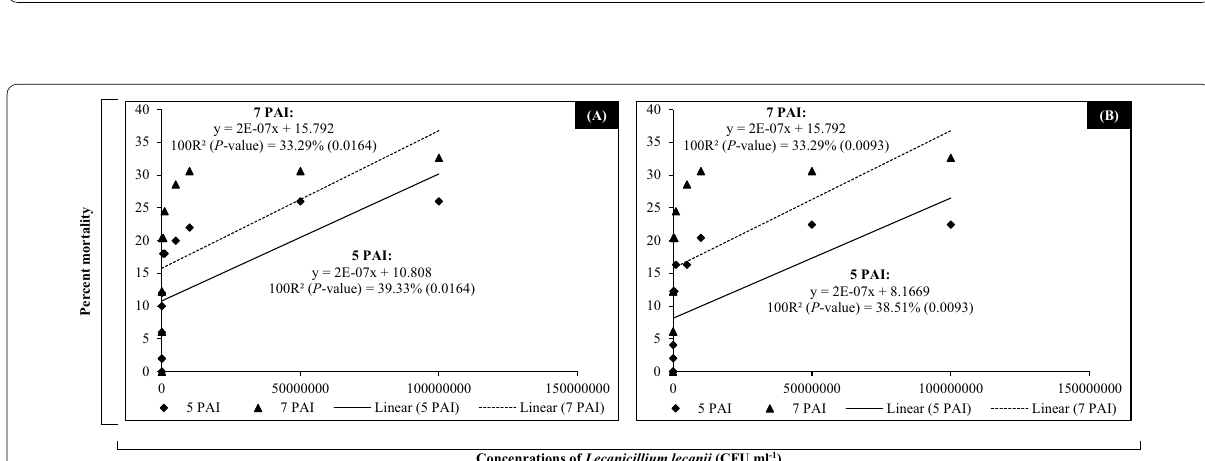
Fig. 7 Linear regression equation (Ŷ b ax), coefficient of determination (100R 2 ), and scatter diagram showing the fitted simple regression line = ± of Ŷ [percent mortality of adult male Bactrocera zonata (a) and adult female Bactrocera zonata (b) ] on X [Concentrations of Lecanicillium lecanii ] at different days post-application